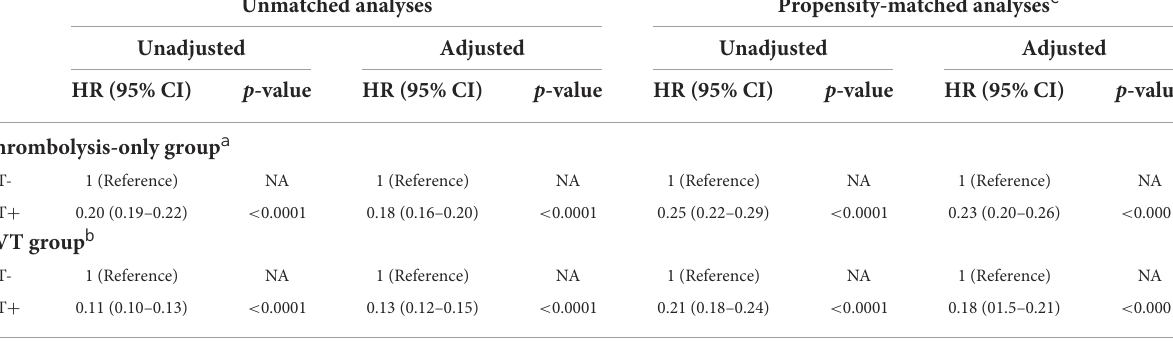
TABLE 2 Cox regression and propensity-matched analyses for IRT and all-cause in-hospital mortality in patients with reperfusion therapy. Unmatched analyses Propensity-matched analyses c Unadjusted Adjusted Unadjusted Adjusted